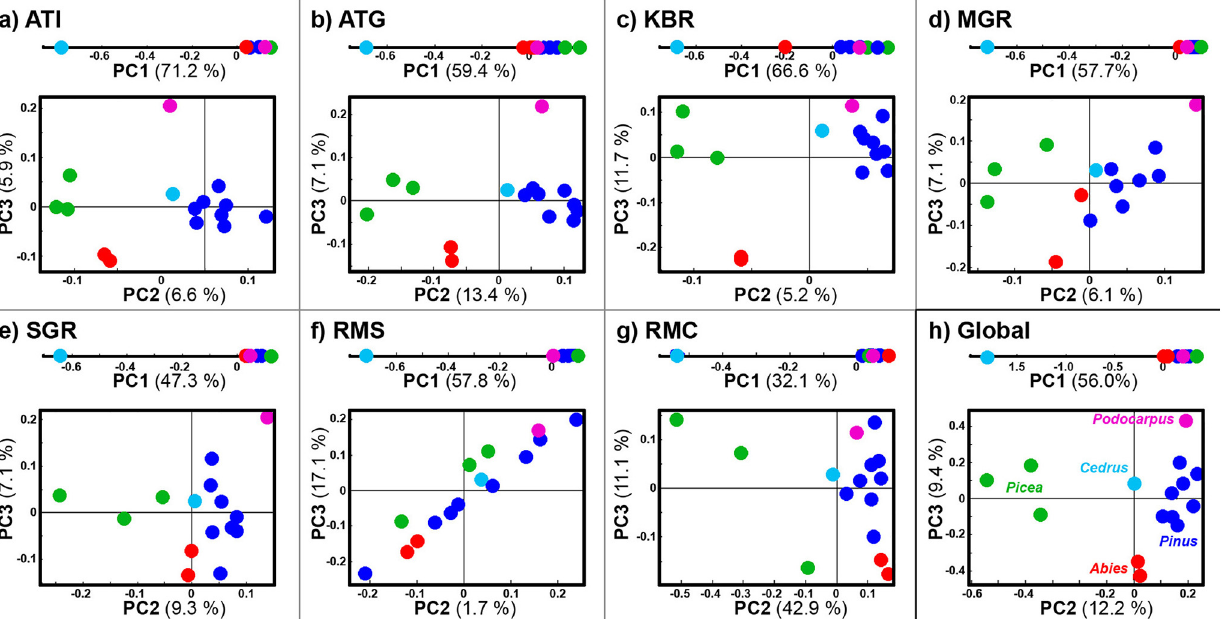
Fig 5. Score plots of individual blocks and global scores of consensus principal component analysis (CPCA). ATR-FTIR of (a) (ATI) intact pollen, (b) (ATG) ground pollen; (c) (KBR) Transmission FTIR of KBr pellets; Transmission IR microspectroscopy of (d) (MGR) multigrain and (e) (SGR) single grain; Raman spectroscopy of (f) (RMS) saccus region and (g) (RMC) corpus region of single pollen grain; (h) Global scores. Samples are labelled in accordance to pollen genus: Abies (red), Picea (green), Pinus (blue), Podocarpus (magenta), and Cedrus (cyan). The percent variances for the PCs are given in supplementary